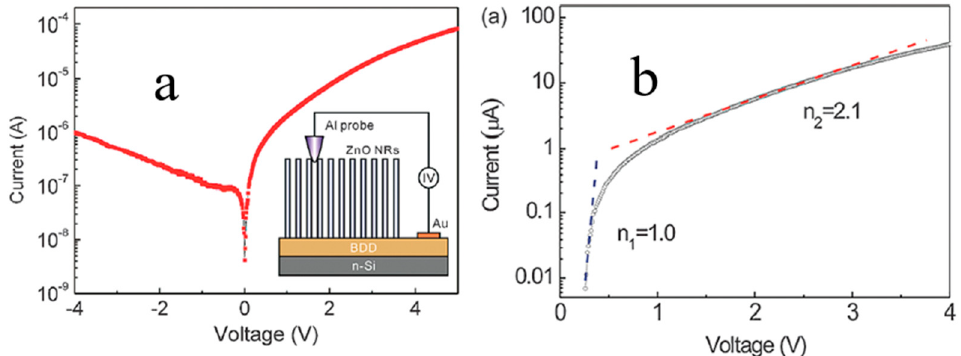
Figure 11. ( a ) The I–V curve of ZnO nanorod (NR)/BDD heterojunction. Insert shows the schematic configuration for conducting measurements. ( b ) The forward-biased ln I–V curve of ZnO NR/BDD heterojunction. A diode ideality factor n 1 = 1.0 in the range from 0–0.3 V and n 2 = 2.1 in the range from 1.2–3.0 V were simulated [82].